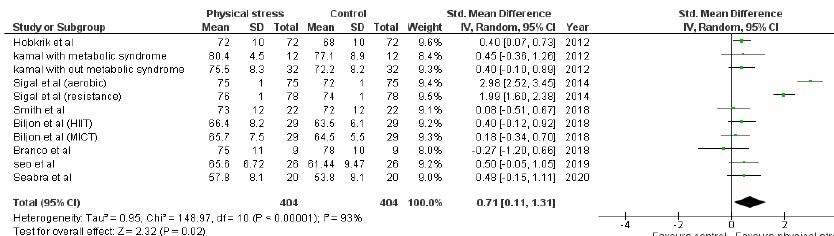
Figure 3. Forest plot showing the results for BMI. Figure 4. Forest plot showing the results for DBP.